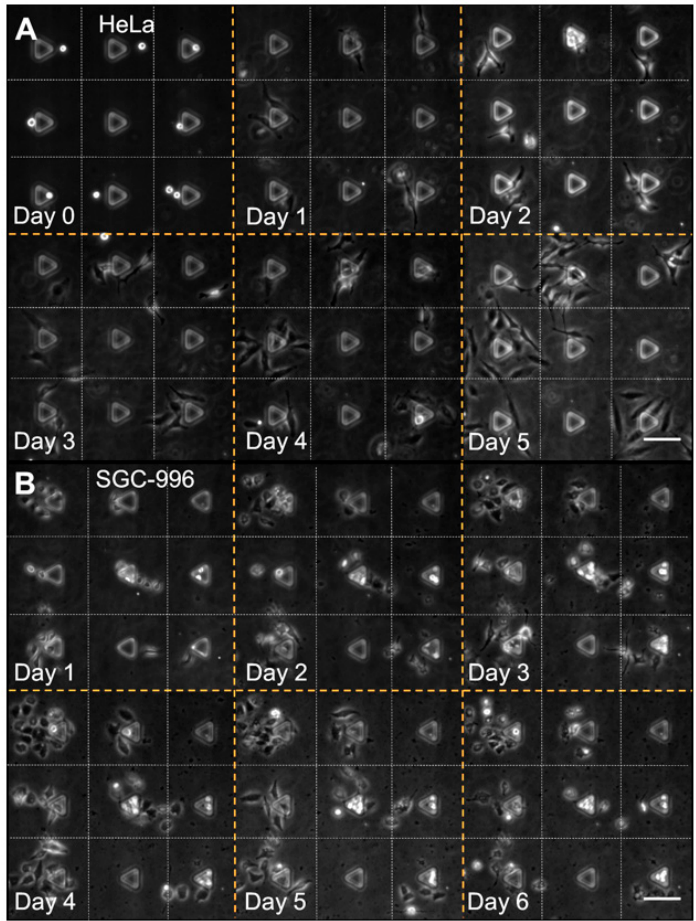
Figure 8. Time-lapse phase contrast images of HeLa cells and SGC-996 cells growing on PLL patterns in our device. ( A ) Patterning performance with HeLa cells on the PLL patterns (non-fluorescently labeled) from DAY 0 to DAY 5. Scale bar is 100 μ m; ( B ) patterning performance with SGC-996 cells on the PLL patterns (non-fluorescently labeled) from DAY 1 to DAY 6. Scale bar is 100 μ m.